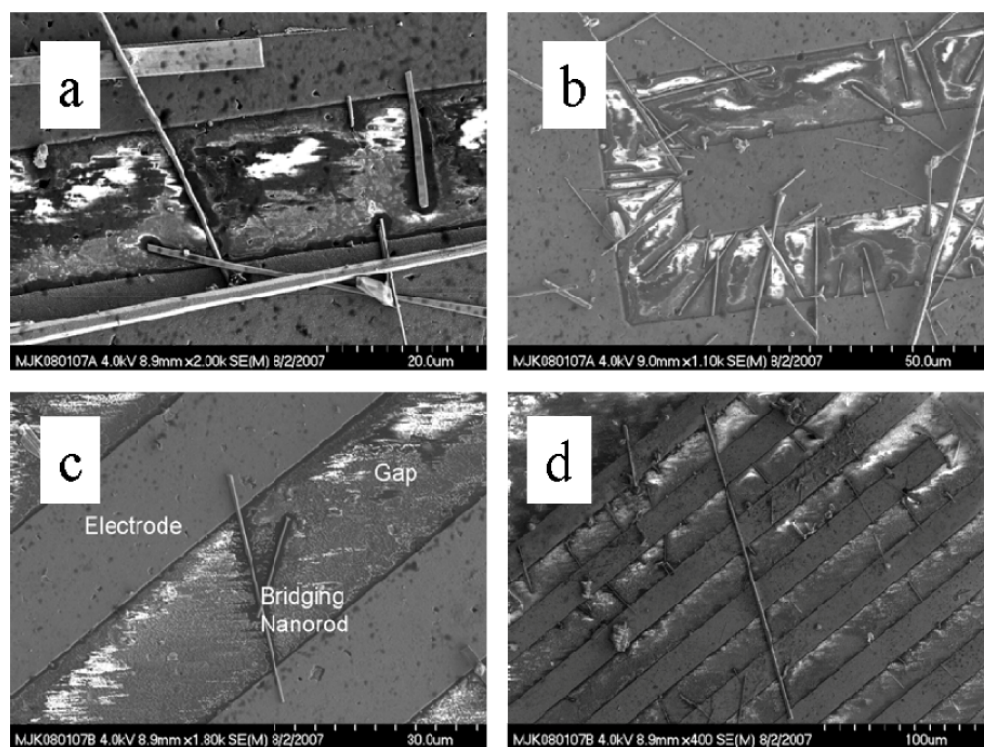
Figure 14. Contact deficits include (a) and (b) failure to bridge and multiple junction contacts between nanowires. (c) suspended nanowires. (d) multiple bridging by a single nanowire.